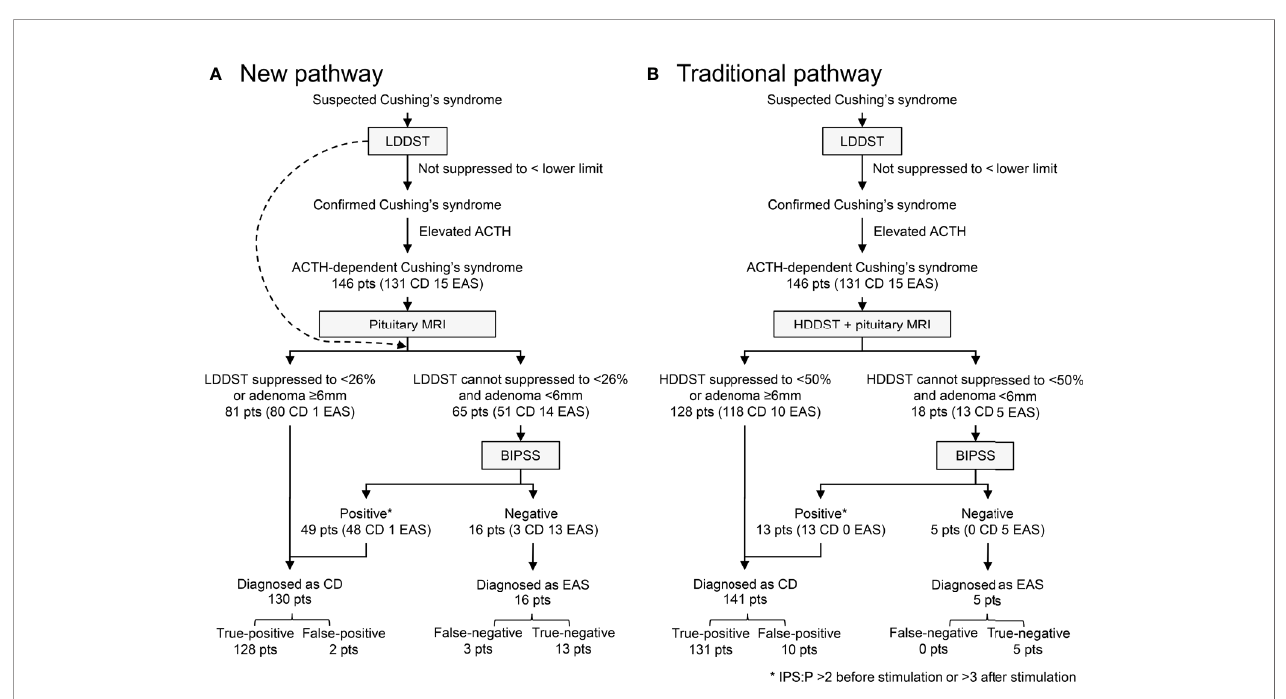
FIGURE 5 | Diagnostic utility of new (A) and traditional (B) pathway. IPS:P refers to inferior petrosal sinus to peripheral ACTH